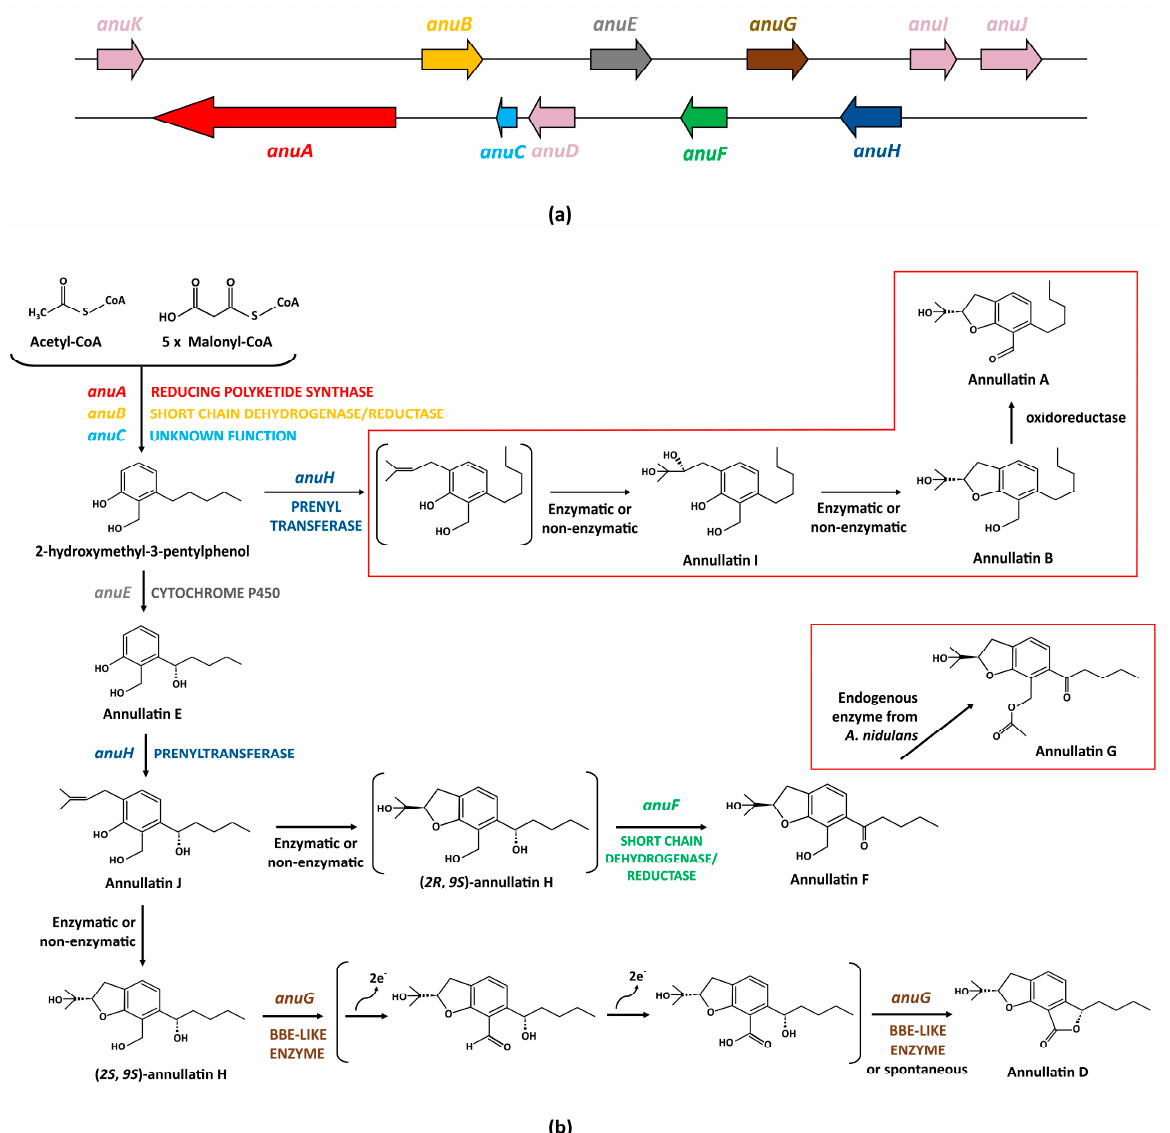
Figure 7. Biosynthesis of Annullatins D and F: ( a ) Annullatin biosynthetic gene cluster in P. roqueforti . The functions of anuD , anuI, and anuG remain unknown. The anuK gene, encoding a hypothetical transcription factor, is discussed below; ( b ) Proposed biosynthetic pathway for Annullatins D and F in P. roqueforti . Hypothetical intermediates are indicated between parentheses. Shunt pathways observed in Aspergillus nidulans are included within red boxes. Adapted from [80].